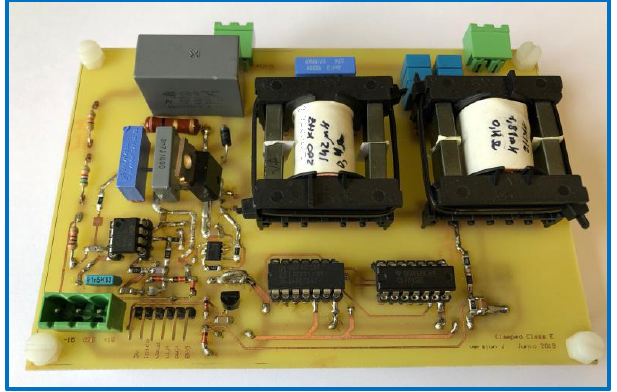
Figure 17. Laboratory prototype.